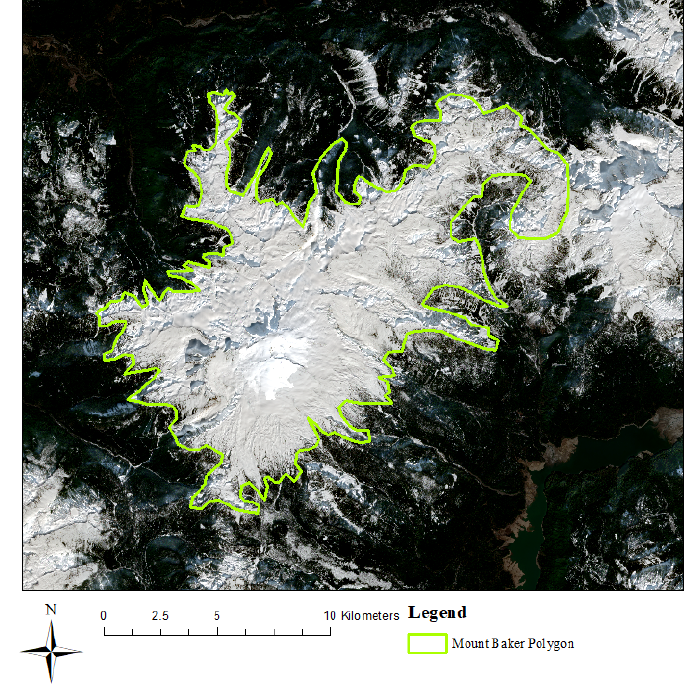
Figure 2: Area of interest over Mount Baker